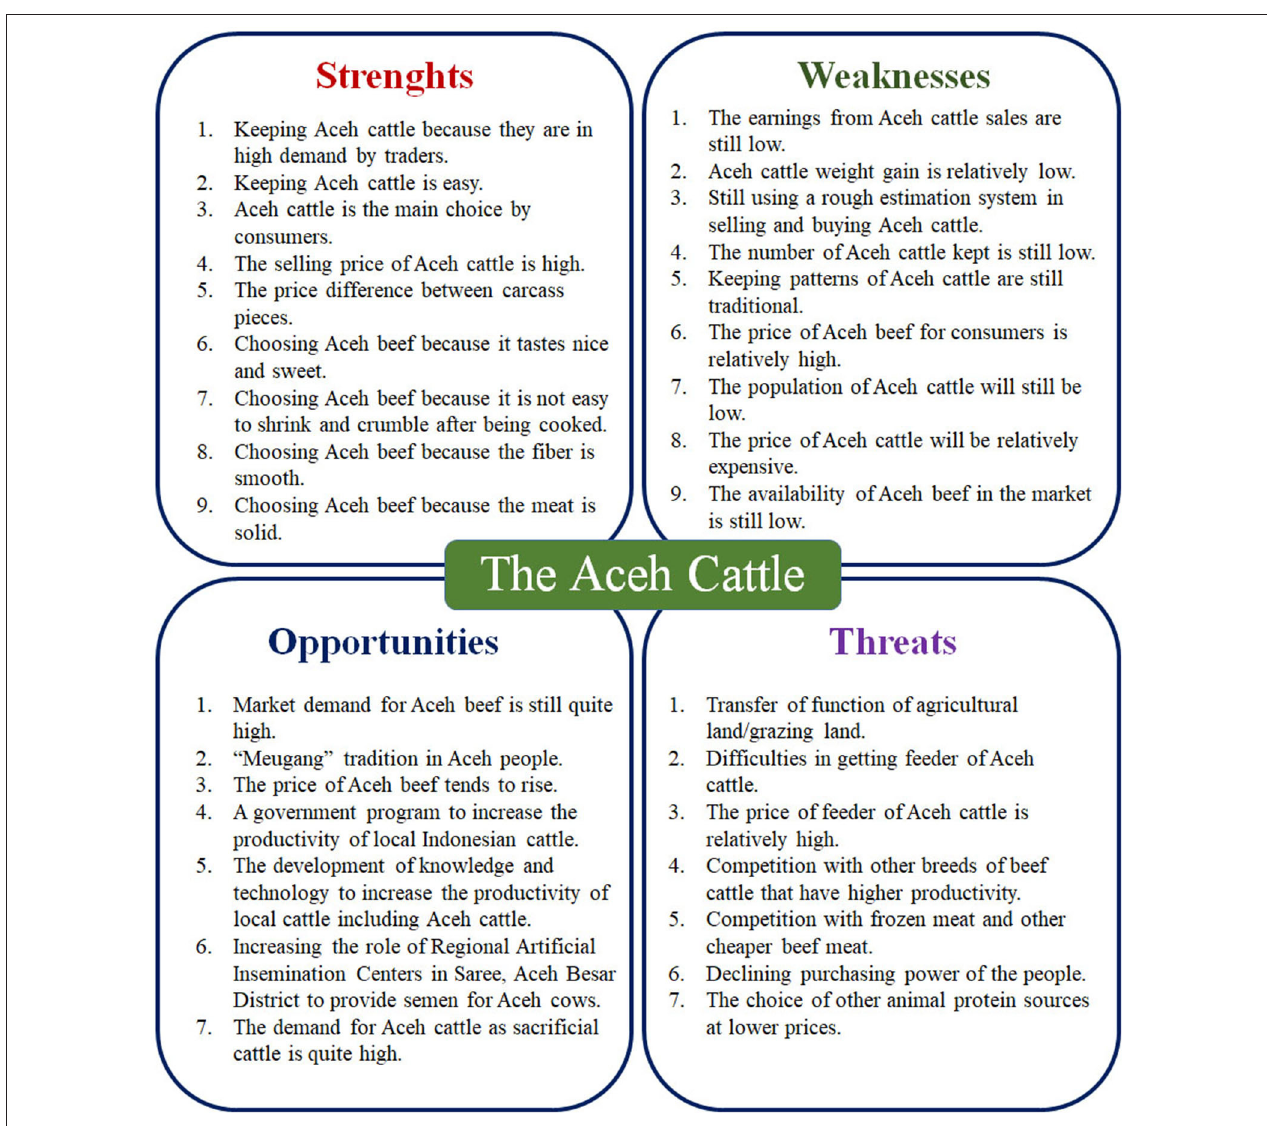
FIGURE 4 | The SWOT (strengths, weaknesses, opportunities, and threats) matrix for identifying the strengths, weaknesses, opportunities, and threats to the economic potential of Aceh development based on the perspective of farmers, traders, and consumers.